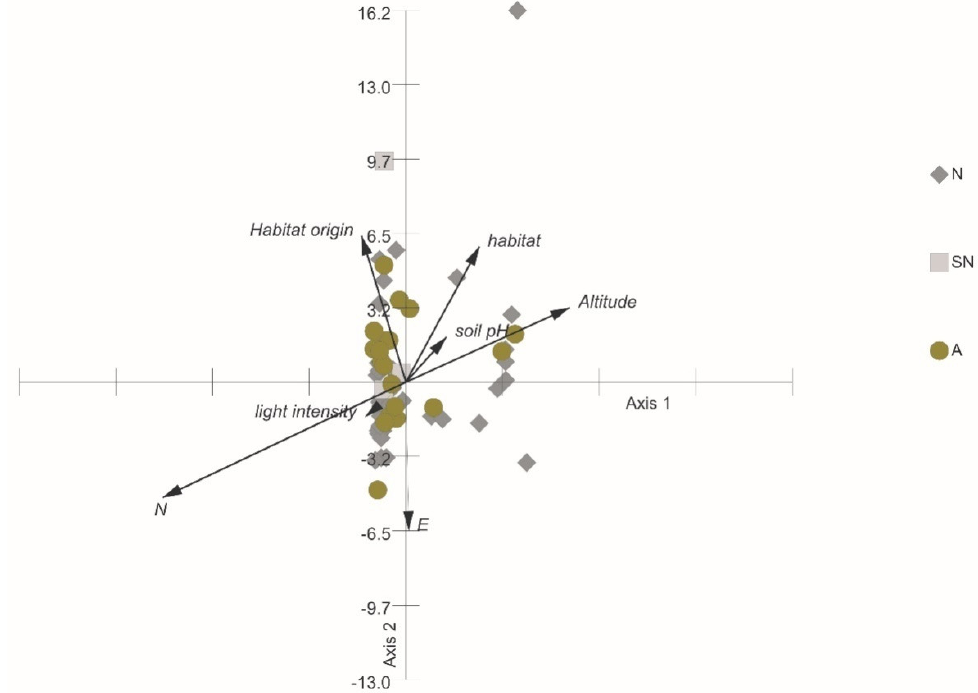
Figure 5. The CCA diagram for Echinocystis lobata fruit parameters per locality with relation to envi- ronmental variables. N, E—geographical position; N, SN, A—habitat origin—natural, seminatural, and anthropogenic.